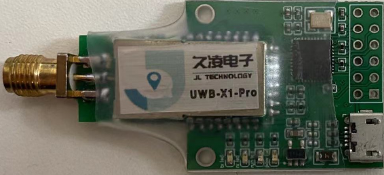
Figure 12. The UWB node. The device we use is produced by China Jiuling electronics manufacturer, whose Chinese name is printed on the surface of the device.